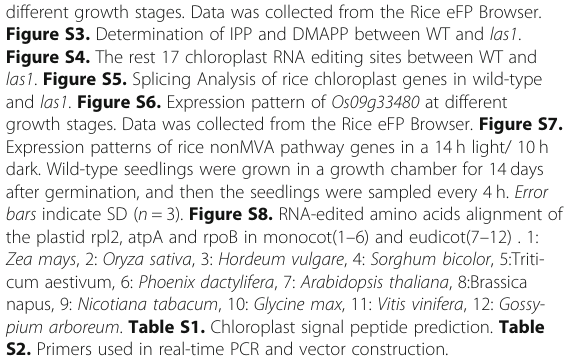
different growth stages. Data was collected from the Rice eFP Browser. Figure S3. Determination of IPP and DMAPP between WT and las1 . Figure S4. The rest 17 chloroplast RNA editing sites between WT and las1 . Figure S5. Splicing Analysis of rice chloroplast genes in wild-type and las1 . Figure S6. Expression pattern of Os09g33480 at different growth stages. Data was collected from the Rice eFP Browser. Figure S7. Expression patterns of rice nonMVA pathway genes in a 14h light/ 10h dark. Wild-type seedlings were grown in a growth chamber for 14days after germination, and then the seedlings were sampled every 4 h. Error bars indicate SD ( n = 3). Figure S8. RNA-edited amino acids alignment of the plastid rpl2, atpA and rpoB in monocot(1 – 6) and eudicot(7 – 12) . 1: Zea mays , 2: Oryza sativa , 3: Hordeum vulgare , 4: Sorghum bicolor , 5:Triti- cum aestivum, 6: Phoenix dactylifera , 7: Arabidopsis thaliana , 8:Brassica napus, 9: Nicotiana tabacum , 10: Glycine max , 11: Vitis vinifera , 12: Gossy- pium arboreum . Table S1. Chloroplast signal peptide prediction. Table S2. Primers used in real-time PCR and vector